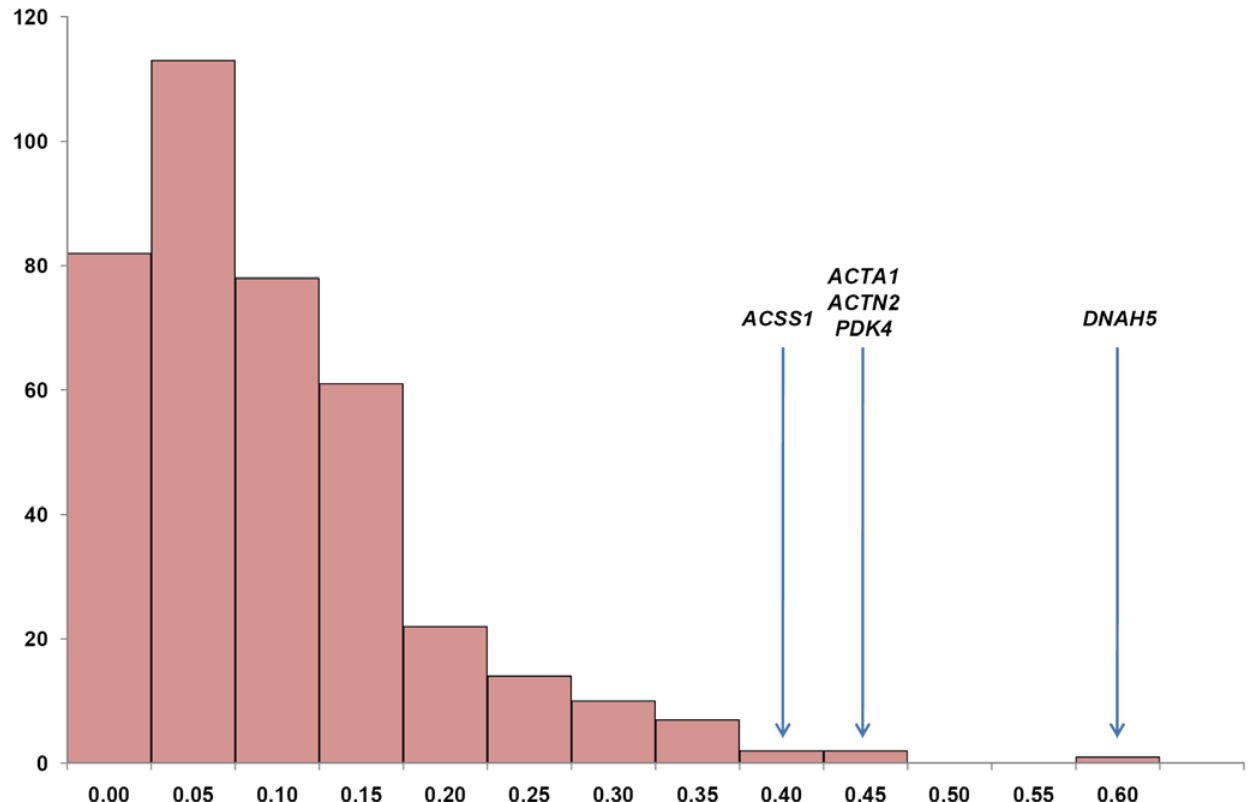
Figure 4. Empirical distribution for F ST . The empirical distribution for global differentiation, F ST (horizontal axis). The vertical axis indicates the number of loci with the corresponding F ST . The positions of the regions that have been subject to positive selection in Thoroughbred are located in the tail-end of the distribution and are indicated by the gene symbols for the strongest candidate genes.